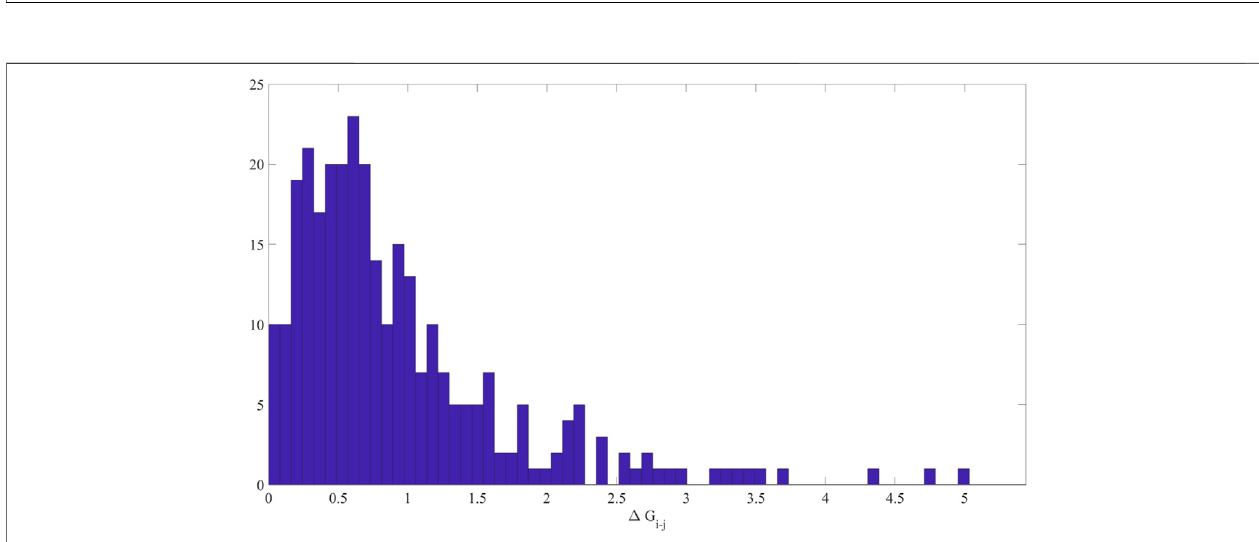
FIGURE 9 | Distribution of the proposed local dependency measure for the improvement and monitoring planning of surface water bodies.